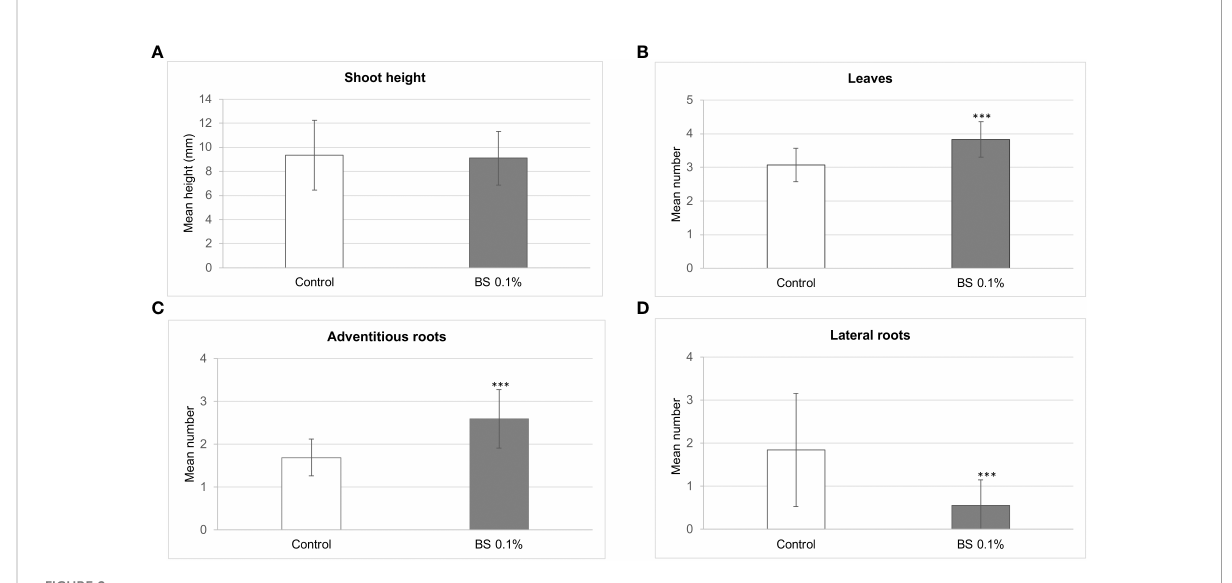
FIGURE 2 Effect of BS treatment on the development of in vitro grapevine plantlets. Micro-cuttings were transplanted in a solid culture medium supplemented with BS (0.1% v/v) or water (as control). The shoot height (A) , number of leaves (B) , adventitious roots (C) , and lateral roots (D) was determined at 4 weeks post transplantation (wpt). Signi fi cant differences were identi fi ed with Student t -test (*** P <